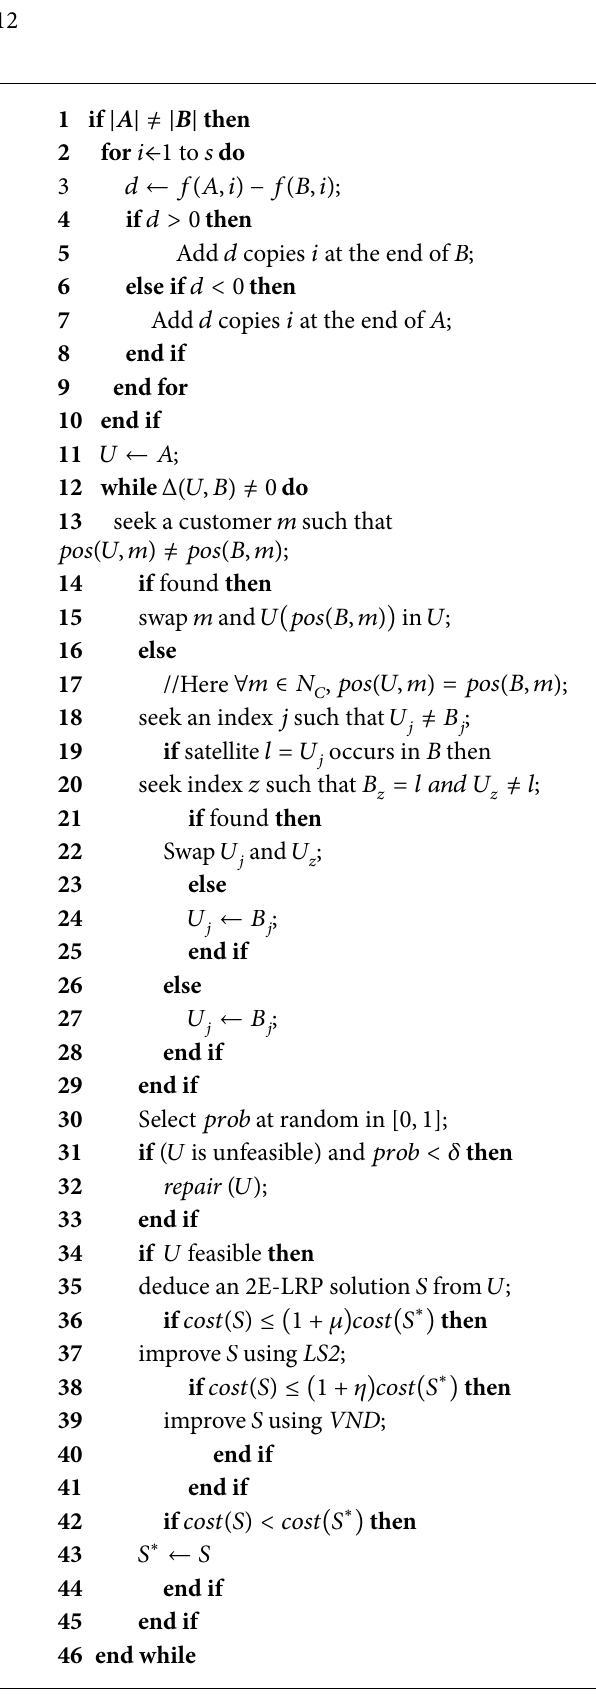
Algorithm 2: PR procedure PR (𝐴,𝐵)